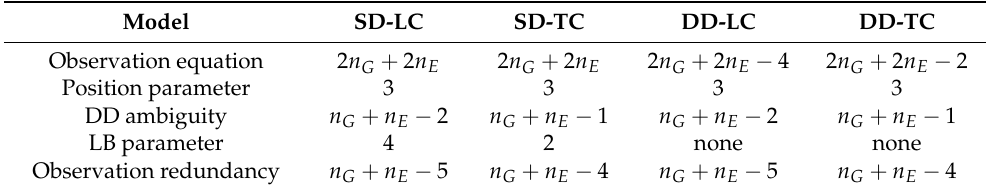
Table 1. Comparison of the SD-LC, SD-TC, DD-LC, and DD-TC models in the single-epoch solution.